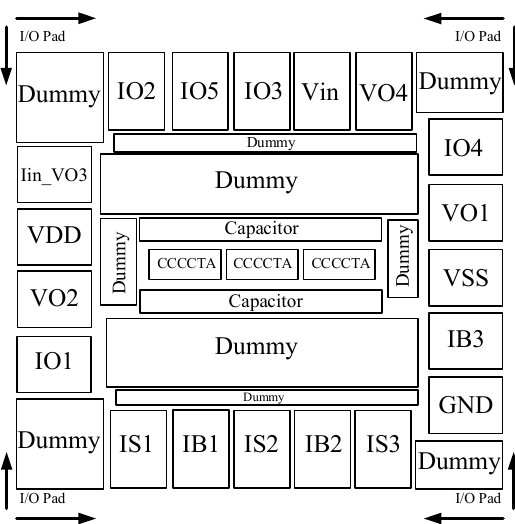
Figure 14. The core of the proposed mixed-mode biquadratic filter.